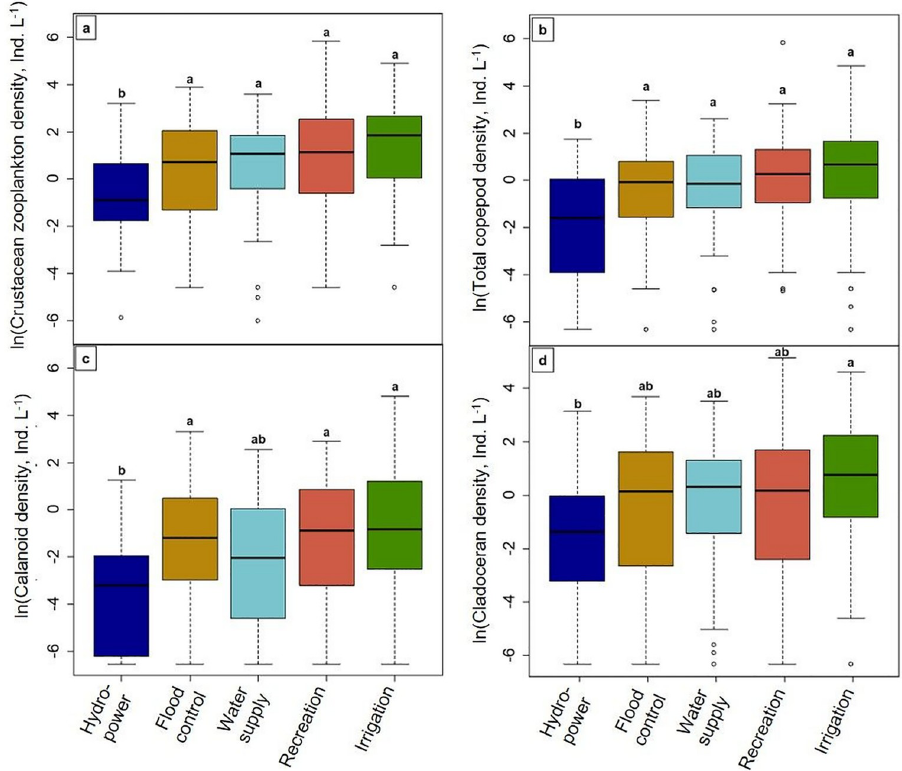
Fig 6. Relationships between reservoir primary purpose and a) total crustacean zooplankton, b) total copepods, c) calanoids, and d) cladocerans. Letters above each boxplot denote statistical differences of zooplankton among reservoir primary